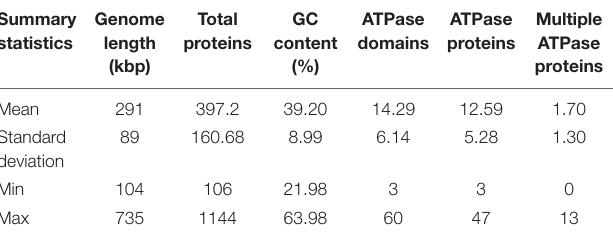
Summary statistics